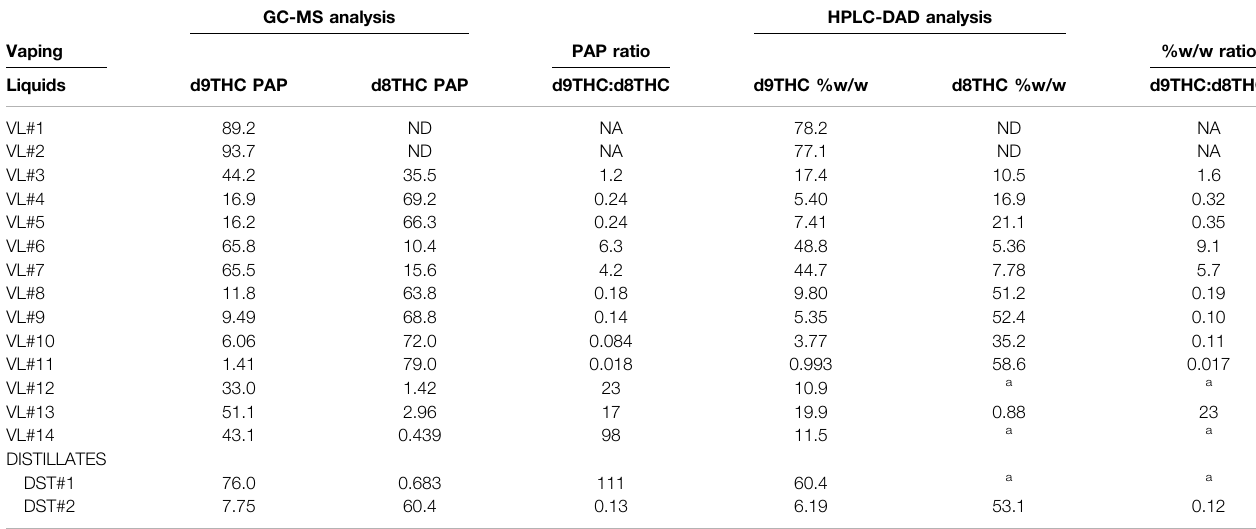
TABLE 2 | Comparison of GC-MS peak area percentages (PAP) and HPLC-DAD quantitative analysis (%w/w) for d9THC and d8THC in vaping liquids and bulk THC